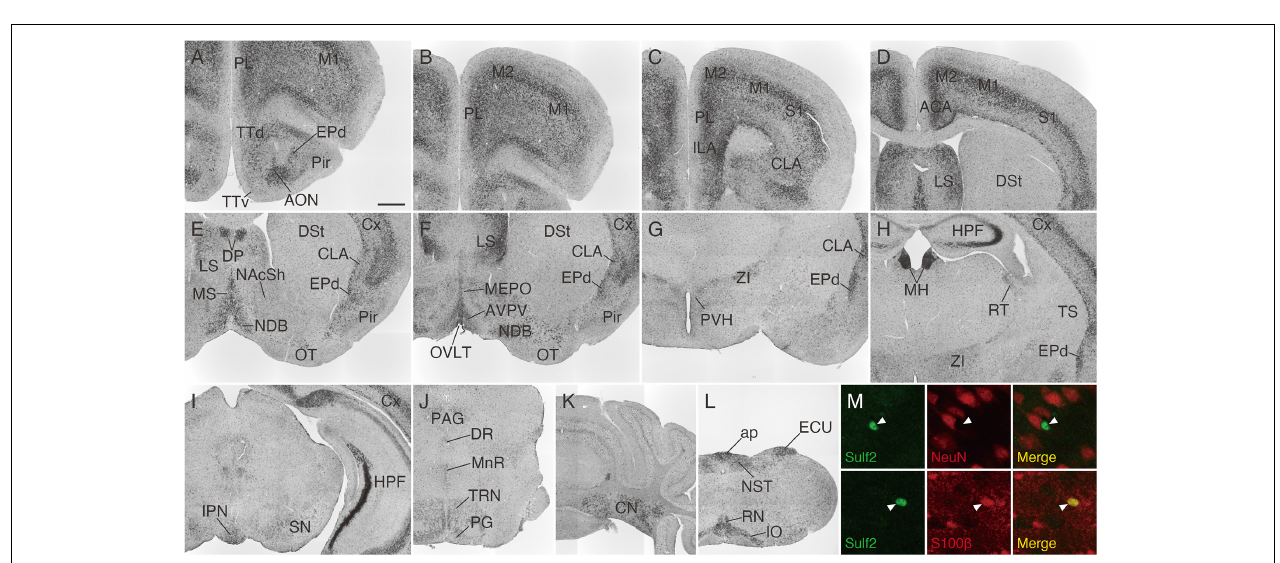
FIGURE 7 | Sulf2 mRNA expression in the adult mouse brain. (A–L) Sulf2 was broadly expressed in the brain. Strong signals were observed in the cerebral cortex (Cx), lateral septal nucleus (LS), medial habenula (MH), hippocampal formation (HPF), cerebellar nuclei (CN), inferior olivary complex (IO), external cuneate nucleus (ECU), and area postrema (ap). (M) Confocal microscopic images of the brain slices from Sulf2 LacZ / + mice stained with anti- β -galactosidase (green) and anti-NeuN or S100 β (red). Representative images of the scattered punctate signals in the thalamic region are shown. The β -galactosidase signals, indicative of Sulf2 expression, were co-localized with an astrocyte marker, S100 β (arrowheads, lower panels), but not with a neuronal marker, NeuN (arrowheads, upper panels). ACA, anterior cingulate area; AON, anterior olfactory nucleus; AVPV, anteroventral periventricular nucleus; CLA, claustrum; DP, dorsal peduncular cortex; DR, dorsal raphe nucleus; DSt, dorsal striatum; EPd, endopiriform nucleus dorsal part; ILA, infralimbic area; IPN, interpeduncular nucleus; M1, primary motor area; M2, secondary motor area; MEPO, median preoptic nucleus; MnR, median raphe nucleus; MS, medial septal nucleus; NAcSh, nucleus accumbens shell; NDB, diagonal band nucleus; NST, nucleus of the solitary tract; OT, olfactory tubercle; OVLT, organum vasculosum of the lamina terminalis; PAG, periaqueductal gray; PG, pontine gray; Pir, piriform cortex; PL, prelimbic area; PVH, paraventricular hypothalamic nucleus; RN, raphe nuclei; RT, reticular nucleus of the thalamus; SN, substantia nigra; S1, primary somatosensory area; TRN, tegmental reticular nucleus; TS, posterior tail of the striatum; TTd, tenia tecta dorsal part; TTv, tenia tecta ventral part; ZI, zona incerta. The scale bars indicate 500 µ m (A–L) and 25 µ m (M) . Approximate AP levels from the bregma (in mm) are 2.5 (A,B) , 2.0 (C) , 0.5 (D,F) , 1.0 (E) , –1.0 (G) , –1.5 (H,M) , –3.5 (I) , –4.5 (J) , –6.5 (K) , and –7.5 (L)